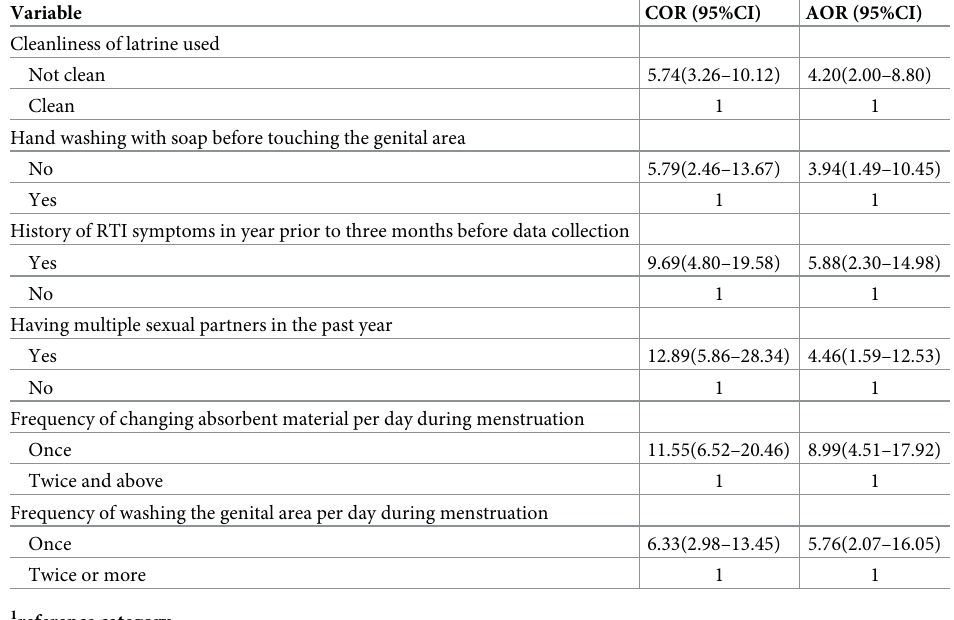
Table 6. Factors associated with RTIs among reproductive age women from multivariable logistic regression analysis.